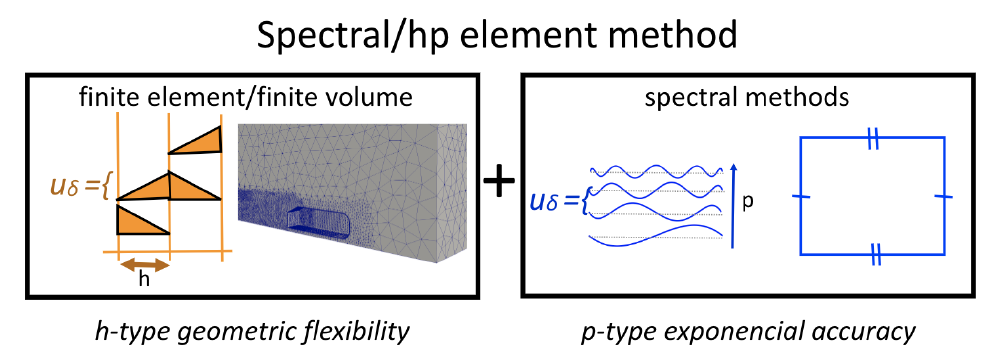
Figure 2. Schematic explanation illustrating how finite element (h) and spectral methods (p) combine to form the spectral/hp element method. Reprinted with permission from [15] 2022